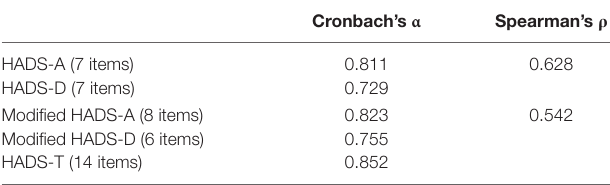
TABLE 5 | Internal reliability of the HADS subscales and total